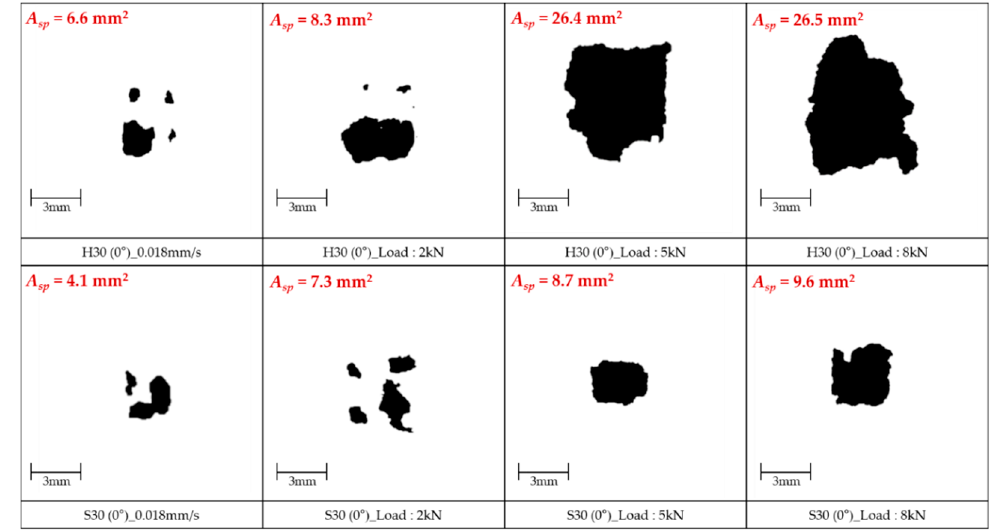
Figure 16. Spalling area of aligned S- and H-fiber specimens according to air pressure.